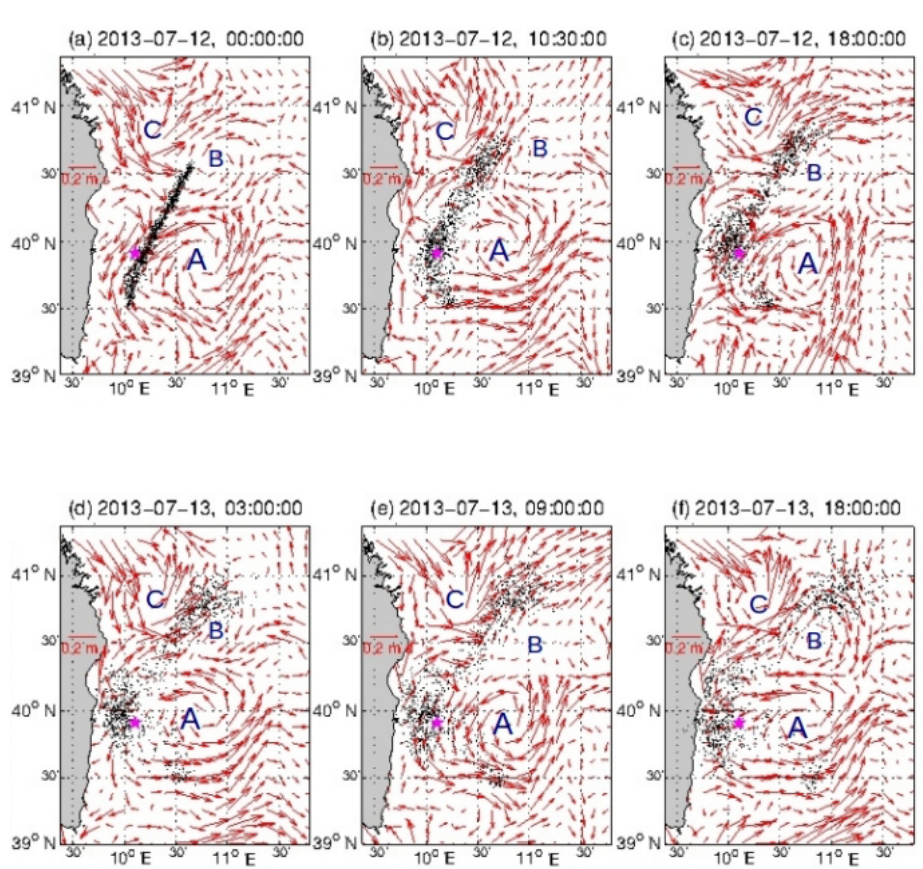
Figure 14. Particles’ dispersion in the Bonaria experiment, overlapped on the hydrodynamic field. Three principal surface structures are visible in the experiment: two cyclonic gyres, A and C, separated by the anticyclonic gyre, B. Cyclones A and C are persistent during the period of the simulation. Most particles are planted along the western external part of the gyre A while the smallest amount is planted between the cyclonic gyre C and the anticyclonic gyre B. After 18h, the particles’ set is separated into two subsets: gyre A drives the larger subset westwards near the Sardinia coast, whereas the variability of the current between gyres C and B drives the remaining particles to the open